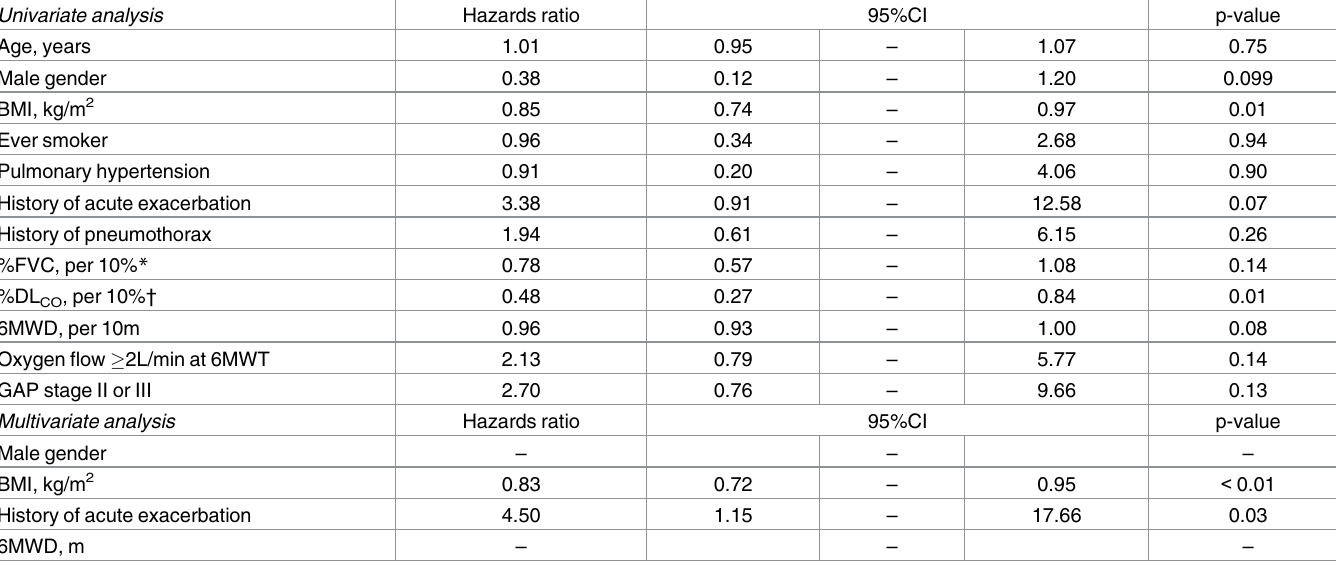
Table 4. Cox proportional hazards model results for evaluating the risk of mortality in patients with idiopathic pulmonary fibrosis (n = 33). Univariate